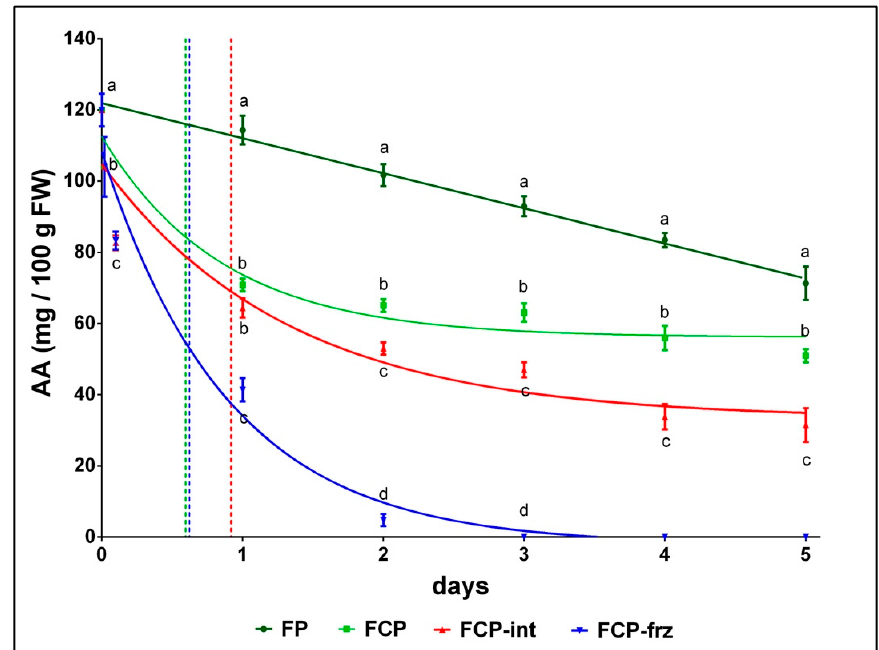
Figure 3. AA kinetics decay in fresh and fresh-cut parsley under different storage conditions, detected with ABA. Values are means ± standard deviation, n = 3. Within each storage time, means followed by unlike letters differ significantly by Fisher’s least significant difference (LSD) test, p ≤ 0.05. Light green, red and blue vertical lines intersect the FCP, FCP-int and FCP-frz curves at their respective half-lives.